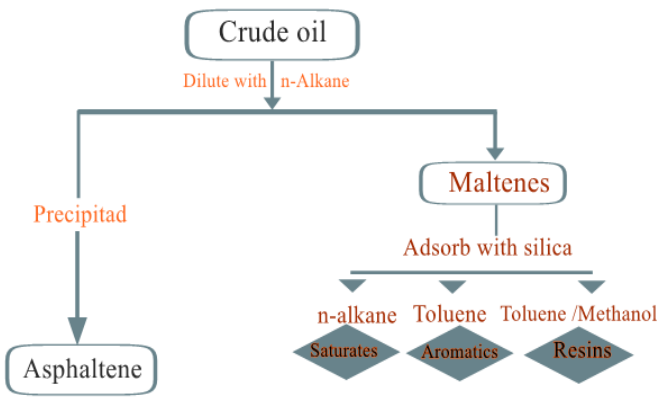
Figure 6. Schematic of SARA fractionation.